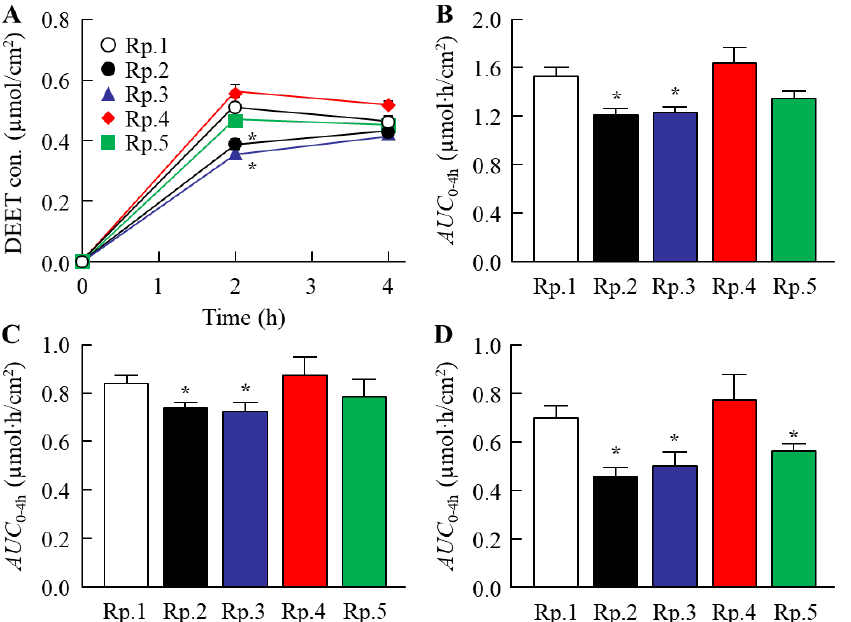
Figure 6. Effect of each CD on DEET penetration in the skin of rats treated with DEET/EtOH/CD (10:40:0.1%) formulations. ( A , B ) Changes in DEET contents ( A ) and AUC 0–4h ( B ) of skin consisting of epithelium and dermis. (C) and (D) Changes in AUC 0 – 4h of skin epithelium ( C ) and dermis ( D ). The compositions of DEET/EtOH/CD formulations (Rp. 1 – 5 formulations) are shown in Table 1. n = 5–7. * p < 0.05 vs. Rp. 1 formulation for each category. The addition of β -CD, HP β CD, and SEB β CD decreased the DEET penetration into the skin tissue.